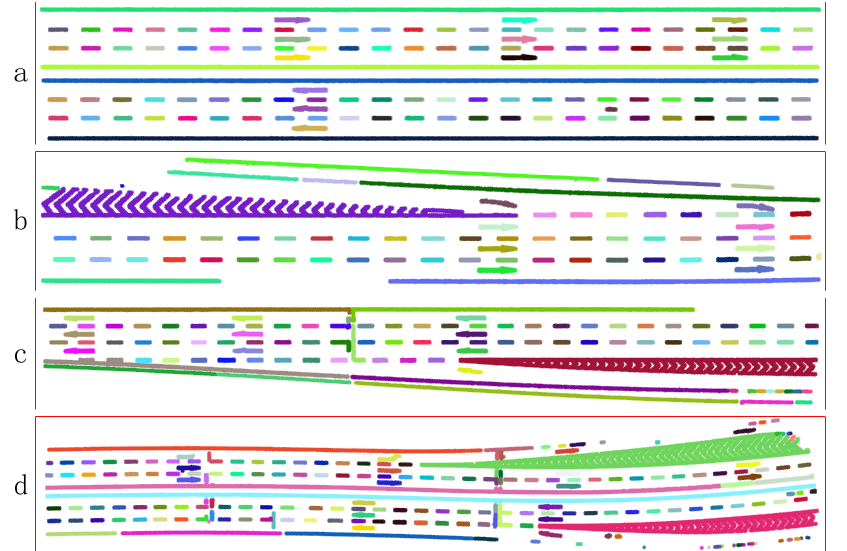
Figure 16. The result of Euclidean clustering (different colors represent different clustering categories). ( a ) Euclidean clustering result of Figure 15a; ( b ) Euclidean clustering result of Figure 15b; ( c ) Euclidean clustering result of Figure 15c; ( d ) Euclidean clustering result of Figure 15d.